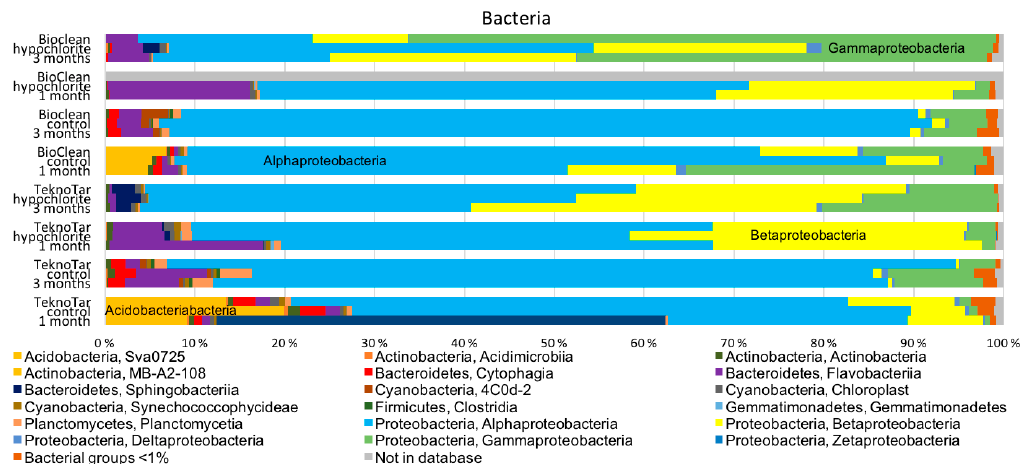
Figure 8. The bacterial community composition on surfaces of BioCleanEco coating and TeknoTar coating in hypochlorite ‐ treated cooling water system and in control system.